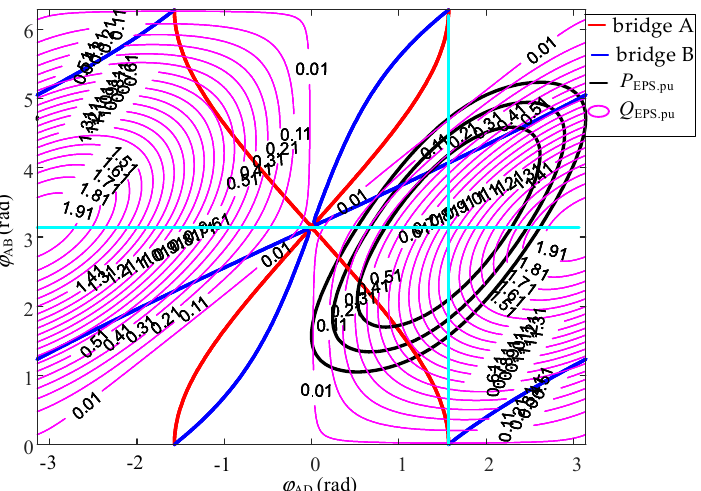
Figure 18. Intersection of different active power standardized values and reactive contour.